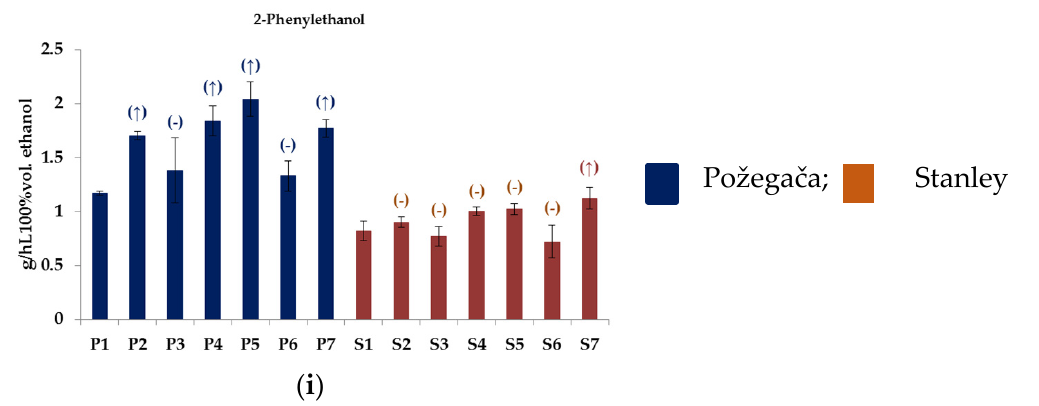
Figure 1. Content of higher alcohols (g/hL 100% vol. ethanol) in plum spirits of Požega č a (P) and Stanley (S) varieties produced by traditional method (P1 and S1) and modi fi ed methods (P2–P7 and S2–S7): ( a ) TA, ( b ) A1, ( c ) A2, ( d ) A3, ( e ) A4, ( f ) A5, ( g ) A6, ( h ) A7, and ( i ) A8. (Codes are listed in Table S1 of Supplementary Materials.) For each plum variety, di ff erent marks indicate di ff erences in the means ( p < 0.05), according to Dunne tt test: ( ↑ ) Statistically signi fi cant higher values compared to values in traditionally produced plum spirit, ( ↓ ): Statistically signi fi cant lower values compared to values in traditionally produced plum spirit, (-): No statistically signi fi cant di ff erences in values compared to values in traditionally produced plum spirit. Concentrations of all parameters are shown as mean ± standard deviation.